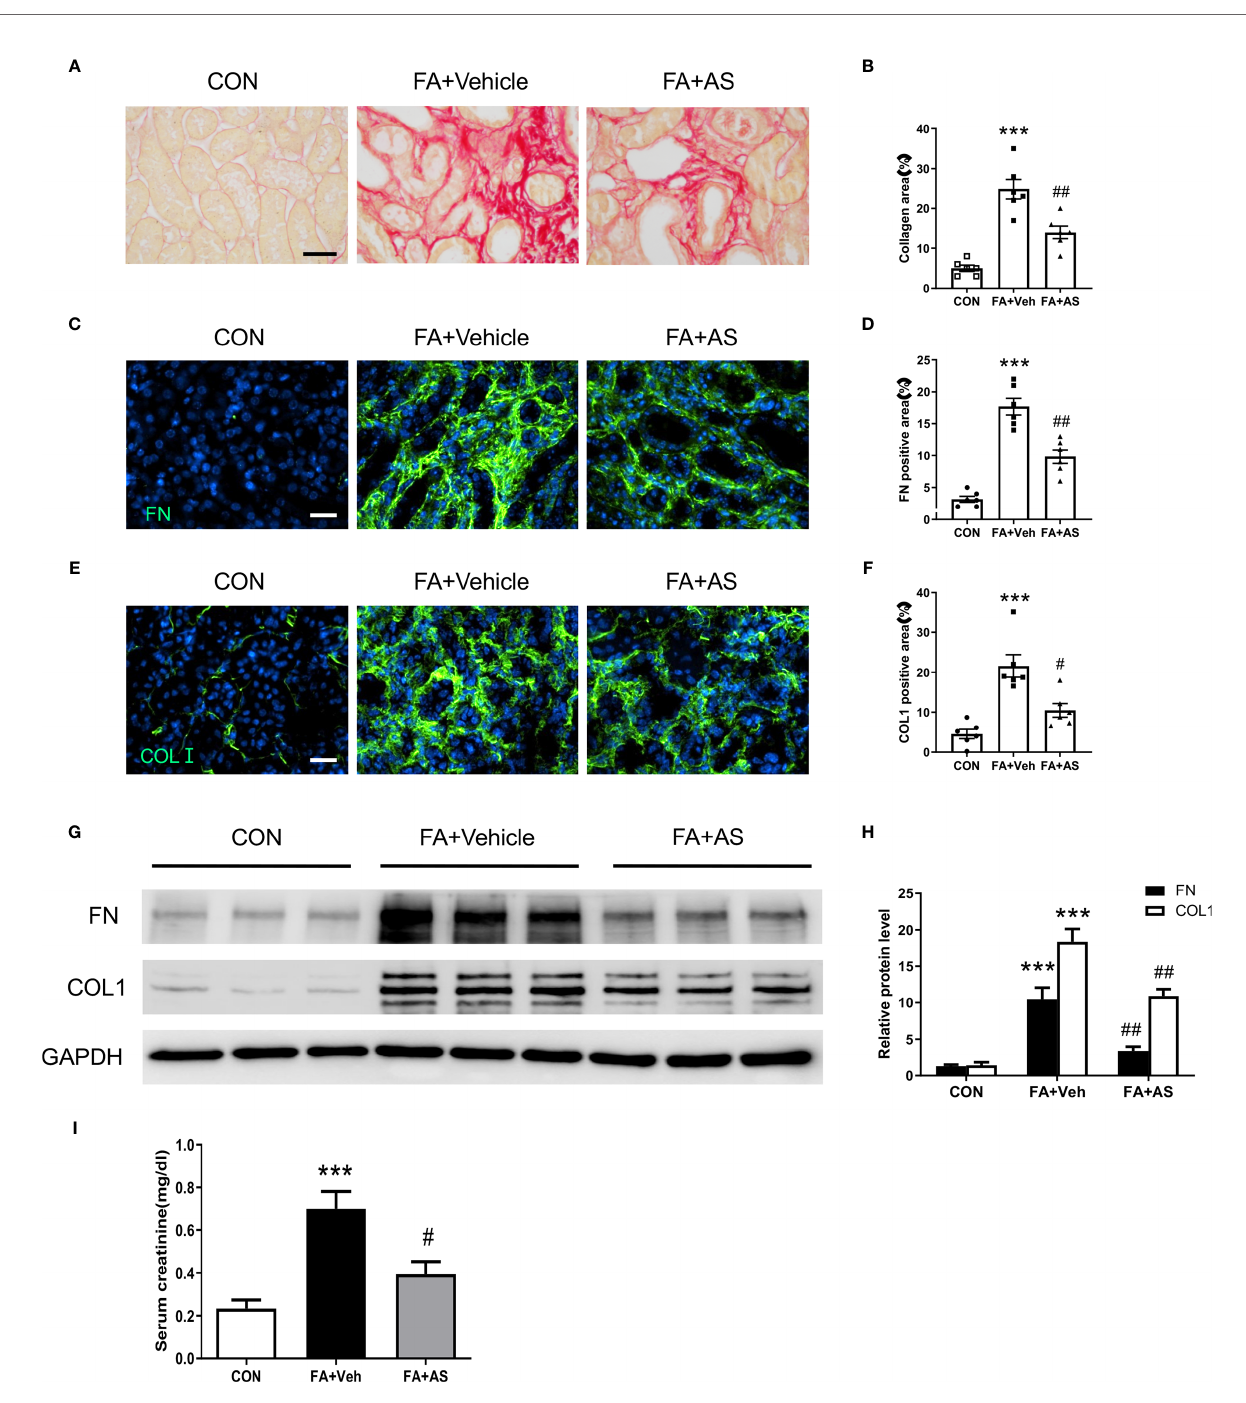
FIGURE 8 | AS1517499 reduces kidney fi brosis and preserve kidney function in folic acid nephropathy. (A) Representative photomicrographs of kidney sections 2 weeks after vehicle or AS1517499 treatment stained with sirius red for evaluation of total collagen deposition in the kidney. Scale bar, 50 m m. (B) Quantitative analysis of interstitial collagen deposition in the kidney. *** P < 0.001 vs CON, ## P < 0.01 vs FA+Veh. n = 6 per group. (C) Representative photomicrographs of kidney sections stained for fi bronectin (green) and counterstained with DAPI (blue). Scale bar, 50 m m. (D) Quantitative analysis of fi bronectin-positive area in FA treated kidneys. *** P < 0.001 vs CON, ## P < 0.01 vs FA+Veh. n = 6 per group. (E) Representative photomicrographs of kidney sections stained for collagen I (green) and counterstained with DAPI (blue). Scale bar, 50 m m. (F) Quantitative analysis of collagen I positive area in the kidney. *** P < 0.001 vs CON, # P < 0.05 vs FA+Veh. n = 6 per group. (G) Representative Western blots showing protein expression of fi bronectin and collagen I in the kidney. (H) Quantitative analysis of protein levels of fi bronectin and collagen I in the kidney. *** P < 0.001 vs CON; ## P < 0.01 vs FA+Veh. n = 6 per group. (I) Effect of AS1517499 on serum creatinine. ** P < 0.001 vs CON; # P < 0.05 vs FA+Veh. n = 6 per